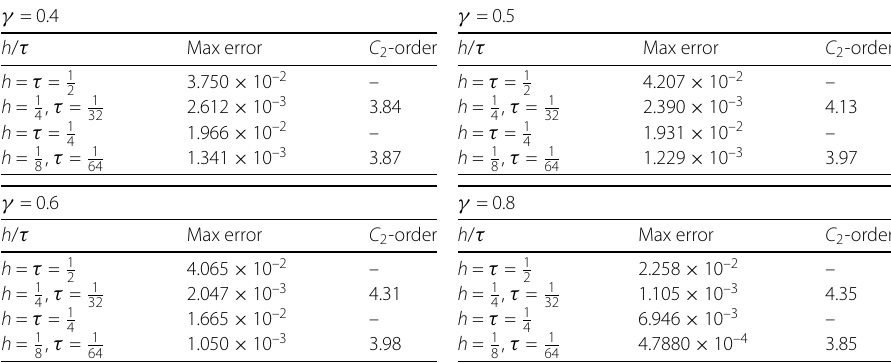
Table 3 C 2 -order of convergence for Test problem 1 γ = 0.4